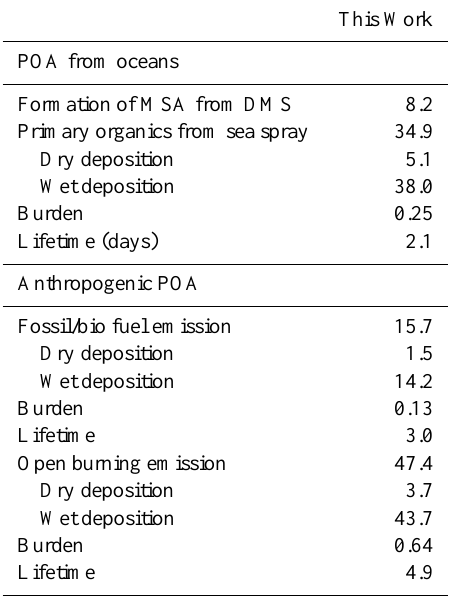
Table 3. Global budgets for organic aerosols from oceans and pri- mary sources (Tgyr − 1 ) ∗